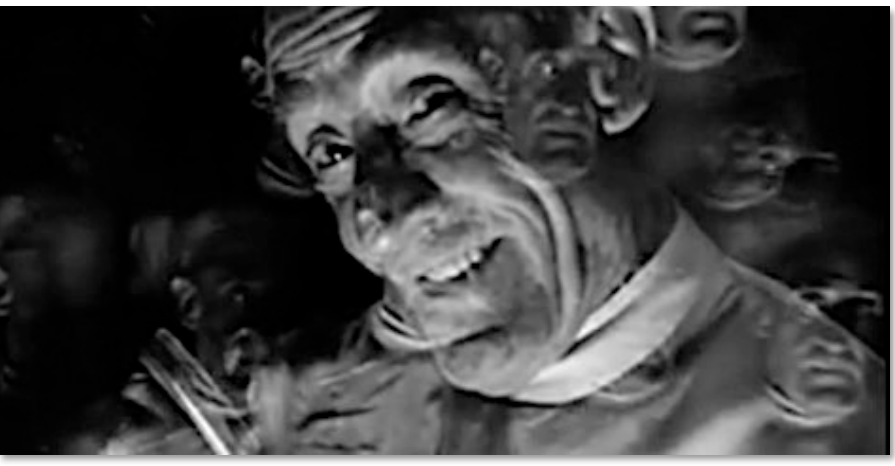
Figure 15. Image from Dark Passage (1947) [37].